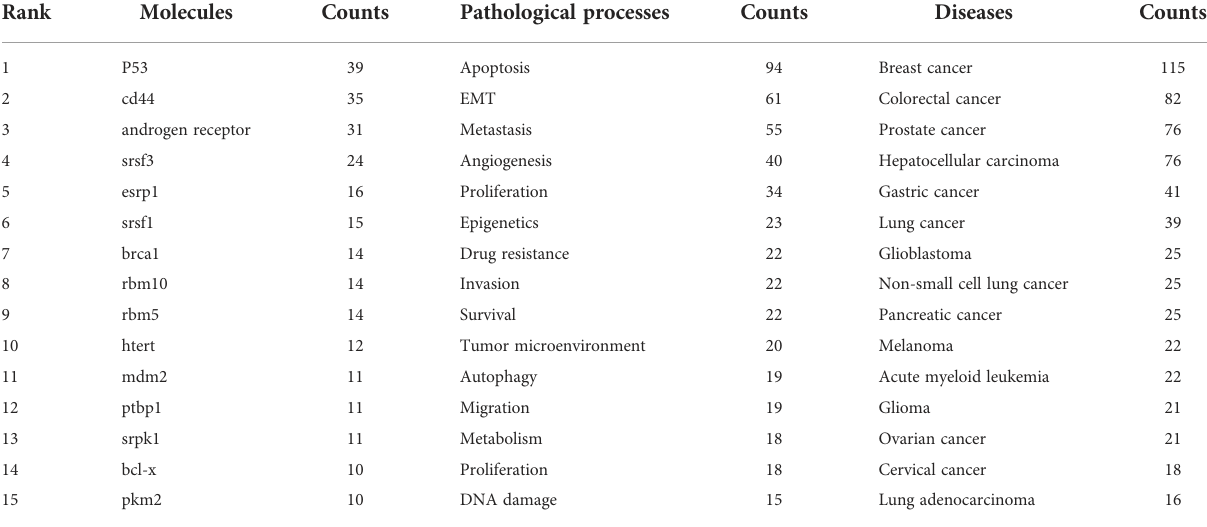
TABLE 6 Top 15 molecules, pathological processes, and diseases related to alternative splicing of